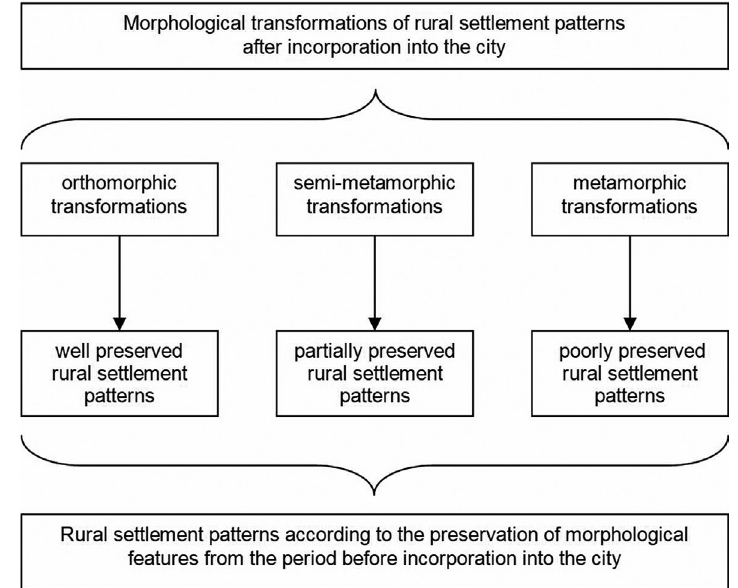
Fig. 8. Model of relations between typologies of morphological transformations and preservation of rural settlement patterns incorporated into the city. Source: own